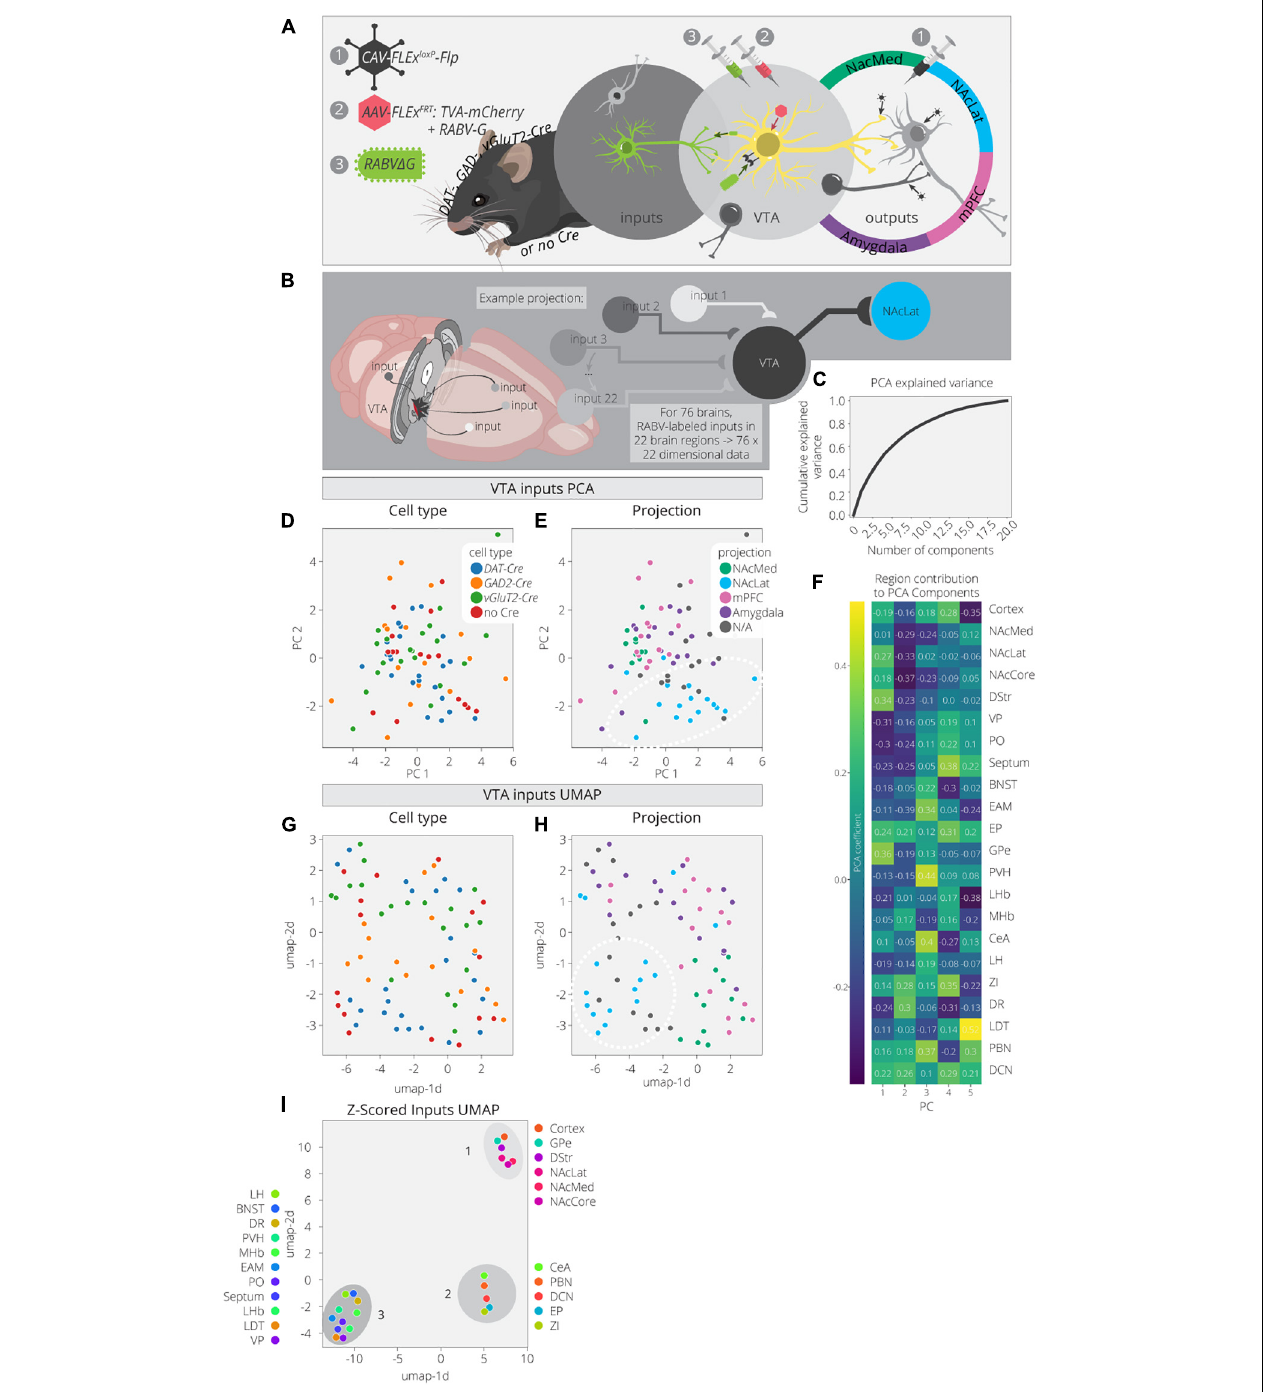
FIGURE 2 | Clusters of VTA inputs revealed by dimensional reduction. (A) Schematic for RABV input labeling experiments. DAT -, GAD -, vGlut2-Cre , and non-Cre-expressing mice were used to identify specific (or non-specific) VTA cell types. Injections of CAV were used to define output sites. (B) Input labeling experiments provided maps of inputs to VTA cells for a combination of different cell-type and projection specifications. Cohort includes 76 brains and 22 input regions counted. (C) Cumulative explained variance from each principal component. (D) Brains are plotted in PCA space for the 1st and 2nd components, colored by cell type. (E) Brains are plotted in PCA space for the 1st and 2nd components, colored by projection. (F) Heatmap of each input region’s contribution to the first five principal components. (G) Brains are plotted in UMAP space, colored by cell type. (H) Brains are plotted in UMAP space, colored by projection. (I) Input regions are plotted in UMAP space, embedded with respect to z-scores across mouse brains. Clusters represent inputs with similar patterns of variation across the cohort.